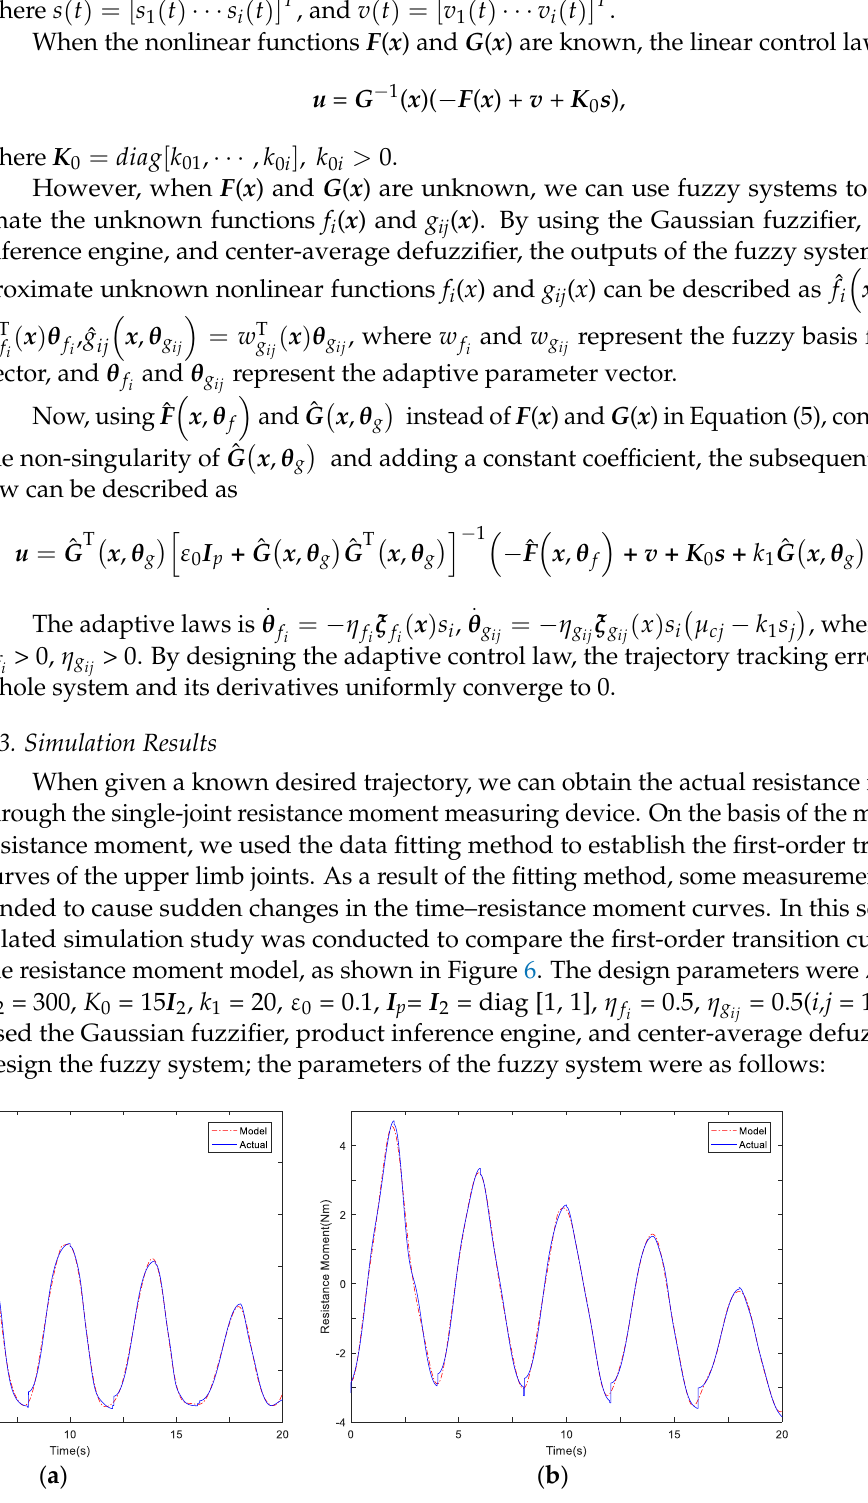
Figure 6. The time–resistance moment curves of upper limb joints: ( a ) shoulder joint; ( b ) elbow joint.